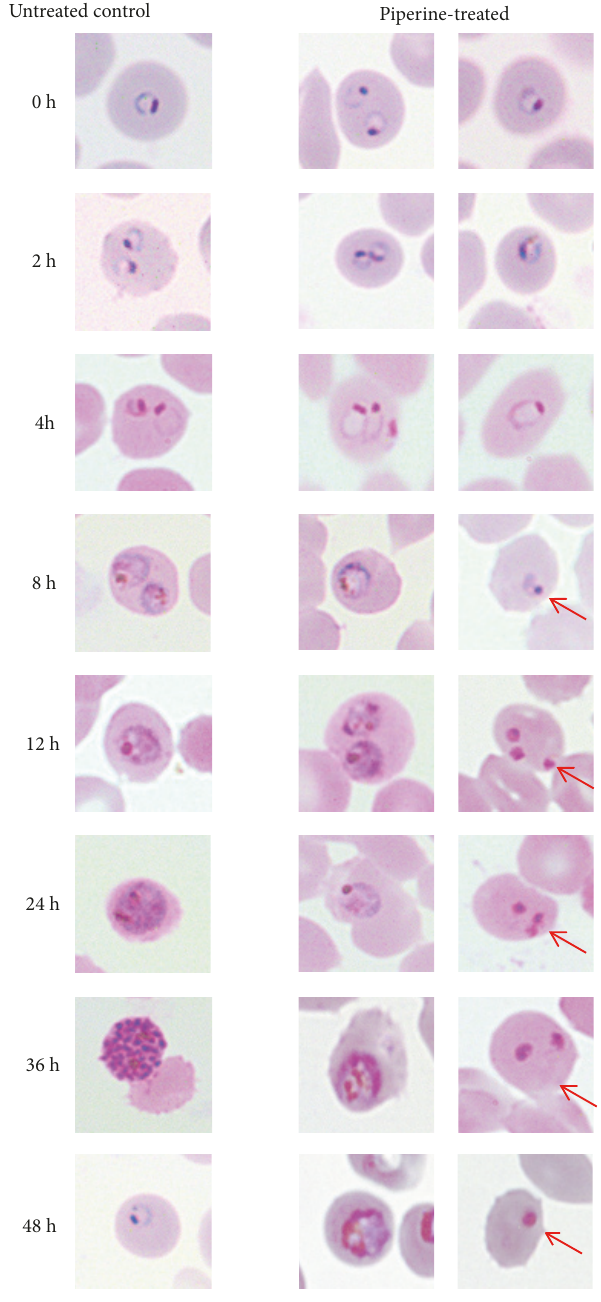
Figure 2: Giemsa-stained thin blood films of 3D7 P. falciparum after exposing to piperine (at IC 50 ) in comparison with untreated control parasite during 0-48 hours period. The red arrow indicates the change in morphology of the exposed